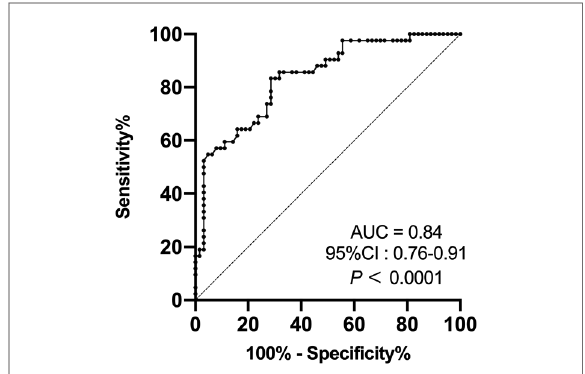
FIGURE 3 Receiver operating characteristic curve of SMA-PI ’ s ability to predict PMV in patient after cardiac valve surgery. SMA-PI, the pulsatility index of the superior mesenteric artery; PMV, prolonged mechanical ventilation; AUC, area under curve; CI, con fi dence interval.